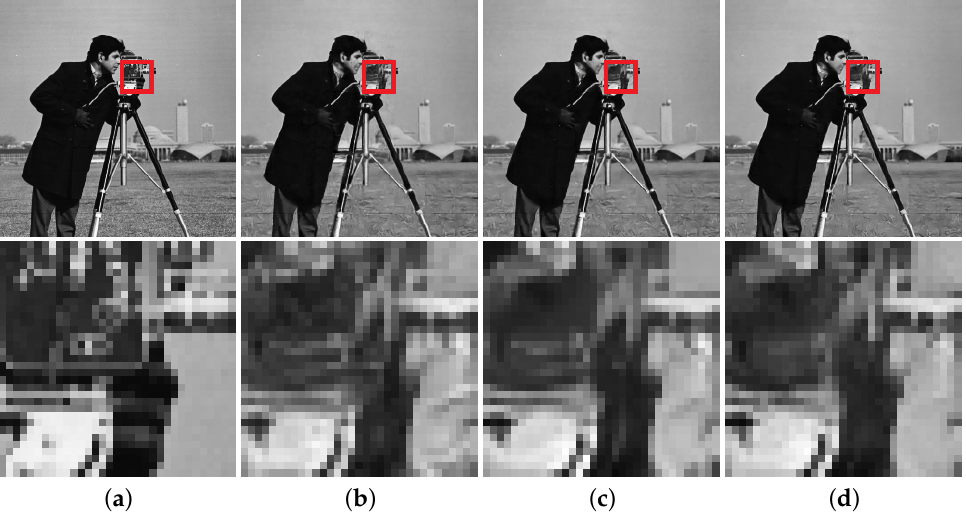
Figure 6. Reconstruction of the cameraman image with a CS ratio 25% using the 9-phase ISTA-Net + (PSNR 28.97dB), 9-phase EPGN (29.62dB), and 7-phase NL-EPGN (29.73dB). ( a ) Ture. ( b ) ISTA-Net + . ( c ) EPGN. ( d )